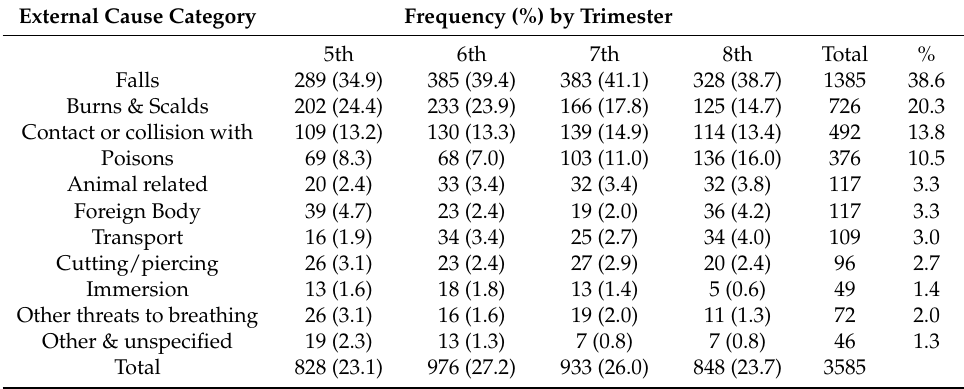
Table 1. Distribution of external causes of injury in children admitted to hospital aged one year, by trimester of